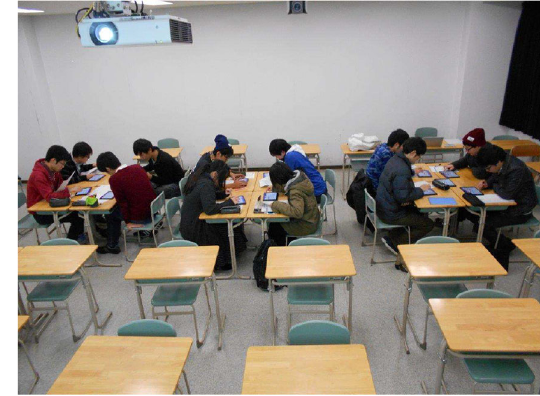
Fig. 13 Scene of activities using the educational application